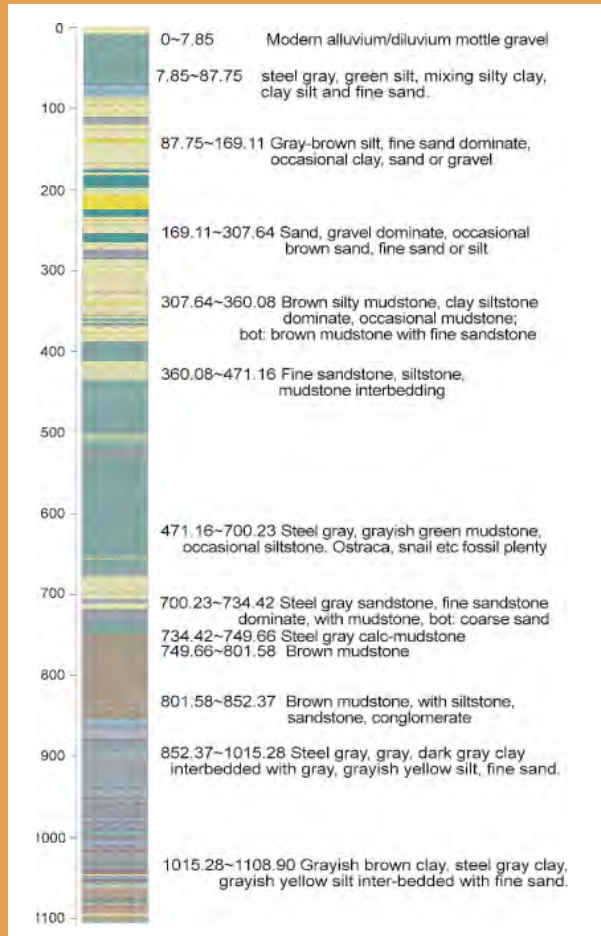
Figure 5. Lithology of the onshore core from Erlang Jian.